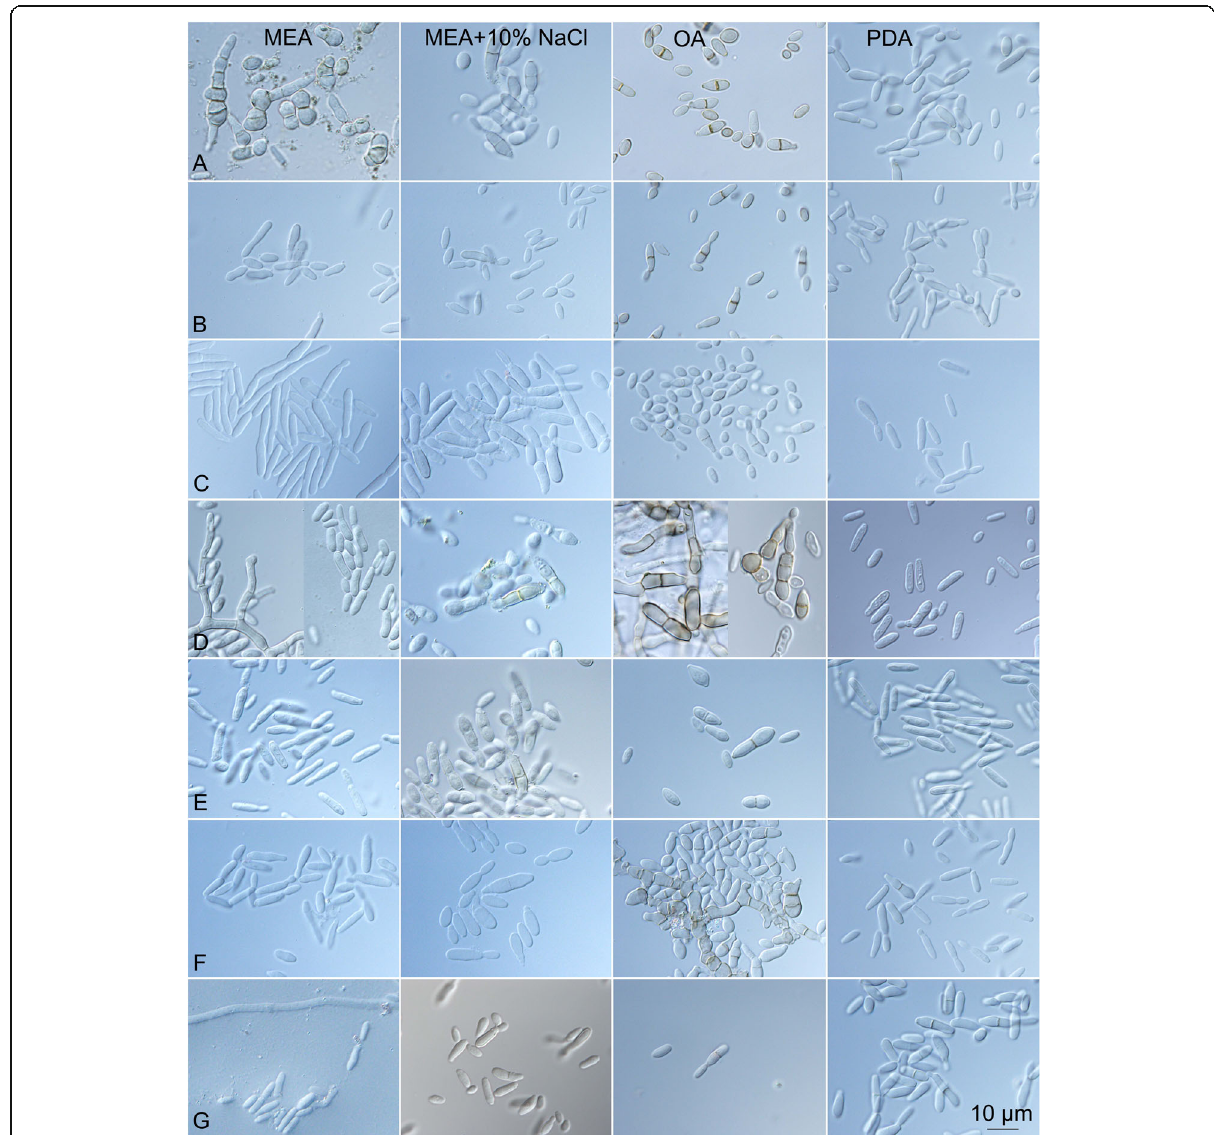
Fig. 10 Micromorphology of Hortaea werneckii strains grown on malt extract agar (MEA) (column 1), MEA + 10% NaCl (column 2), oatmeal agar (column 3) and potato dextrose agar (column 4) for 7 days at 25 °C. a EXF-151 T . b EXF-3846. c EXF-489. d EXF-225. e EXF-161. f EXF-2788. g EXF- 171. Bar = 10 μ m (for